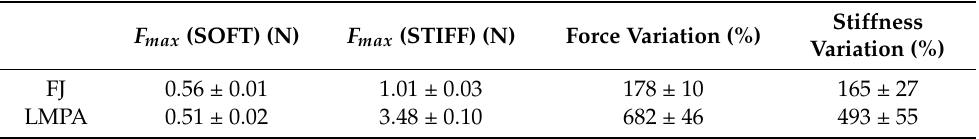
Table 3. Results of the bending tests carried out in bent configuration to evaluate the maximum stiffness variation for the two technologies.